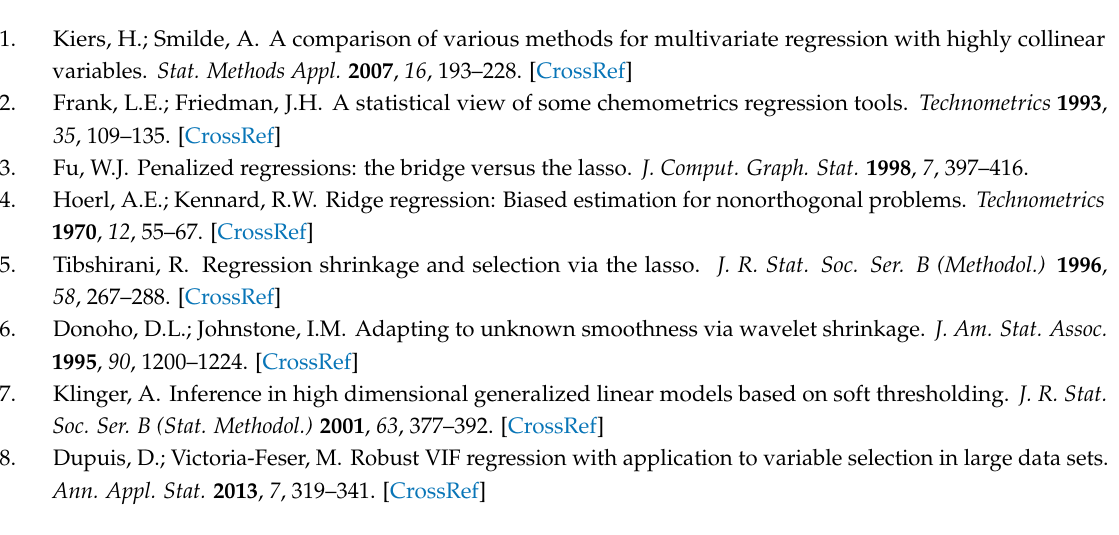
> ( e t ) · β 2 k e k k